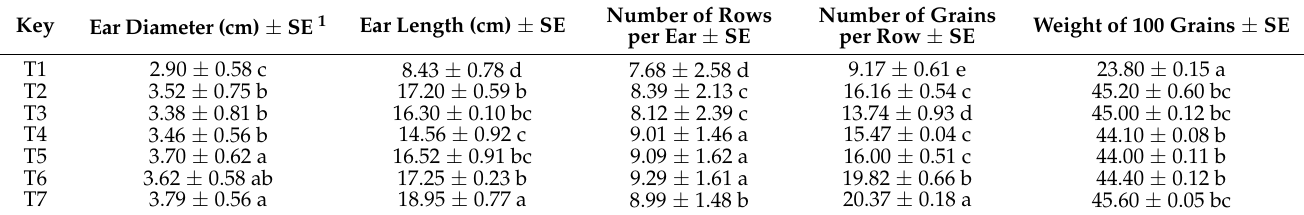
Table 5. Yield data for corn ears.